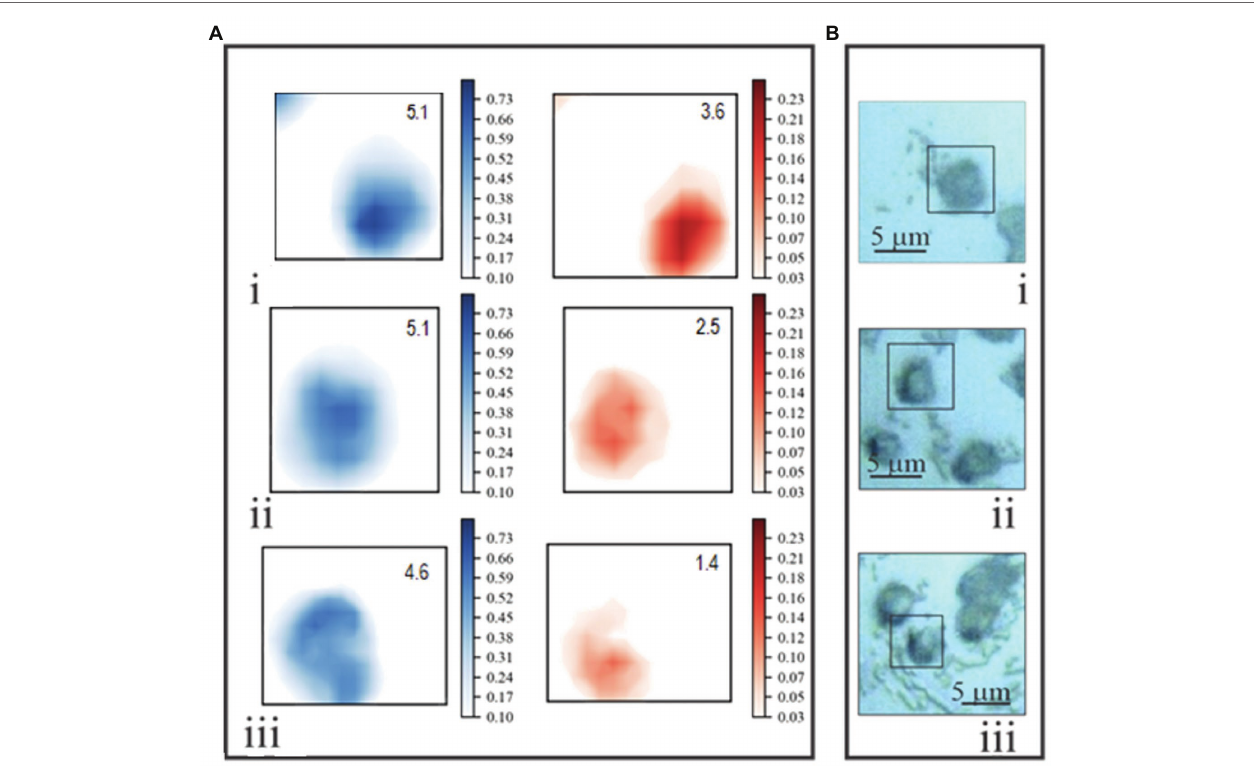
FIGURE 5 | (A) Examples of two-dimensional Raman chemical maps of uninfected E. huxleyi cells (i), and cells 24 (ii) and 48 (iii) hours after being infected with EhV-163. Intensities at 1,002 cm − 1 (protein – blue) and 782 cm − 1 (DNA – red) were mapped using a standard shared color intensity scale for all cells. Integrated pixel intensities (arbitrary units) of “protein portraits” and “DNA portraits” are shown in the top right corner of each box. (B) Reflected bright-field optical micrographs of the same specimens. Rectangles frame areas of each specimen subjected to Raman